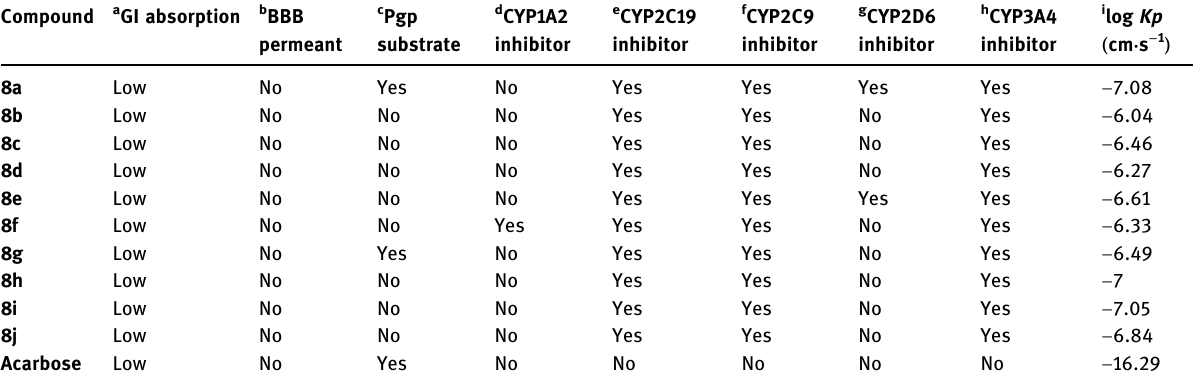
a Gastrointestinal absorption; b blood – brain barrier permeant; c p - glycoprotein substrate; d CYP1A2: Cytochrome P450 family 1 subfamily A